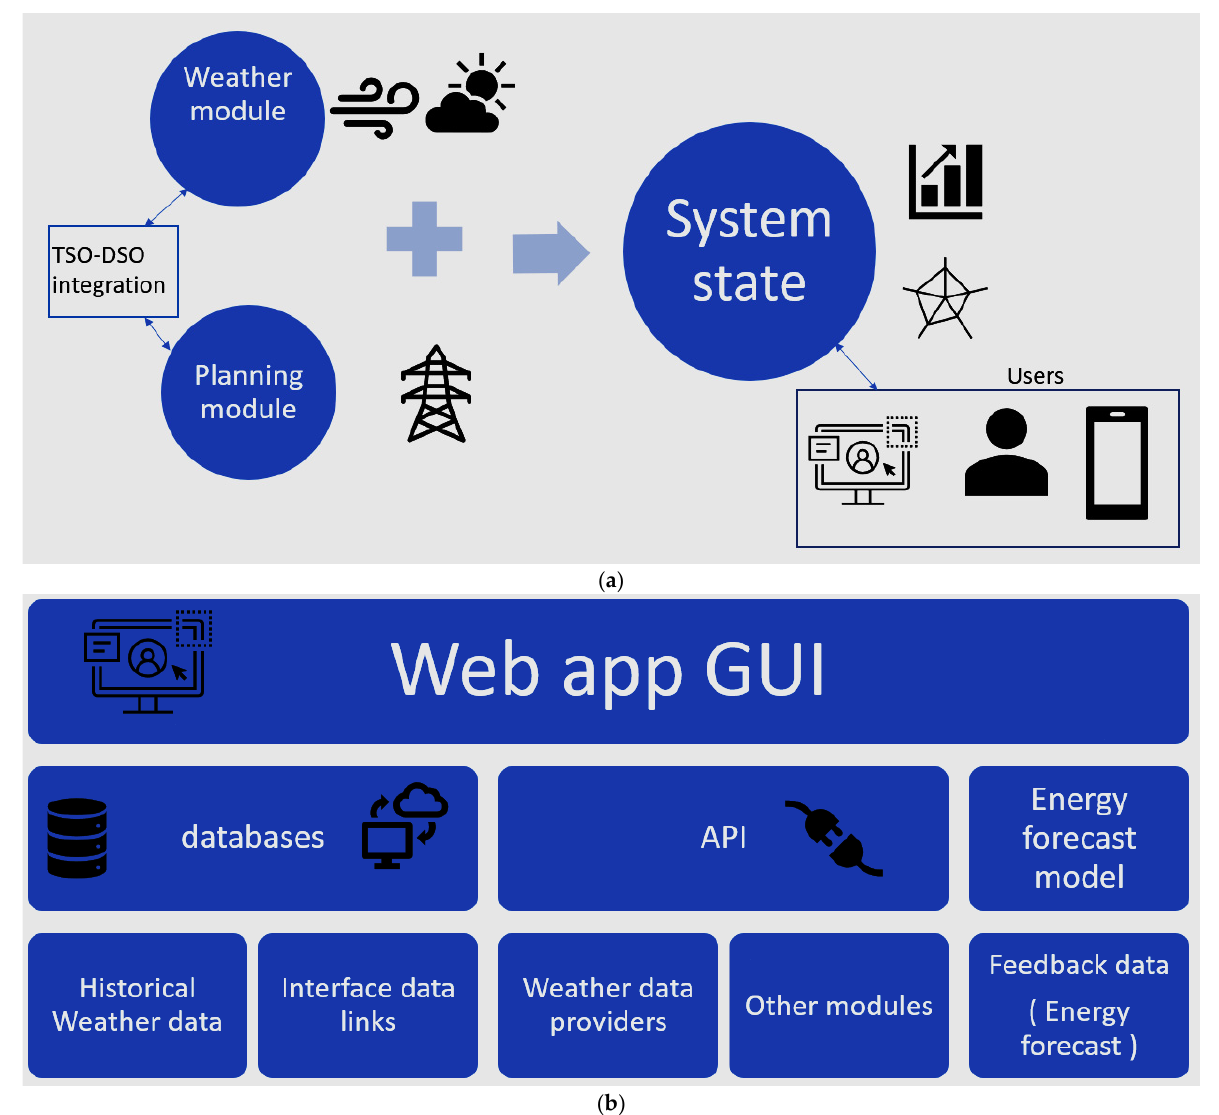
Figure 6. ( a ) Proposed system layout for the F-channel; ( b ) Cloud computing engine.